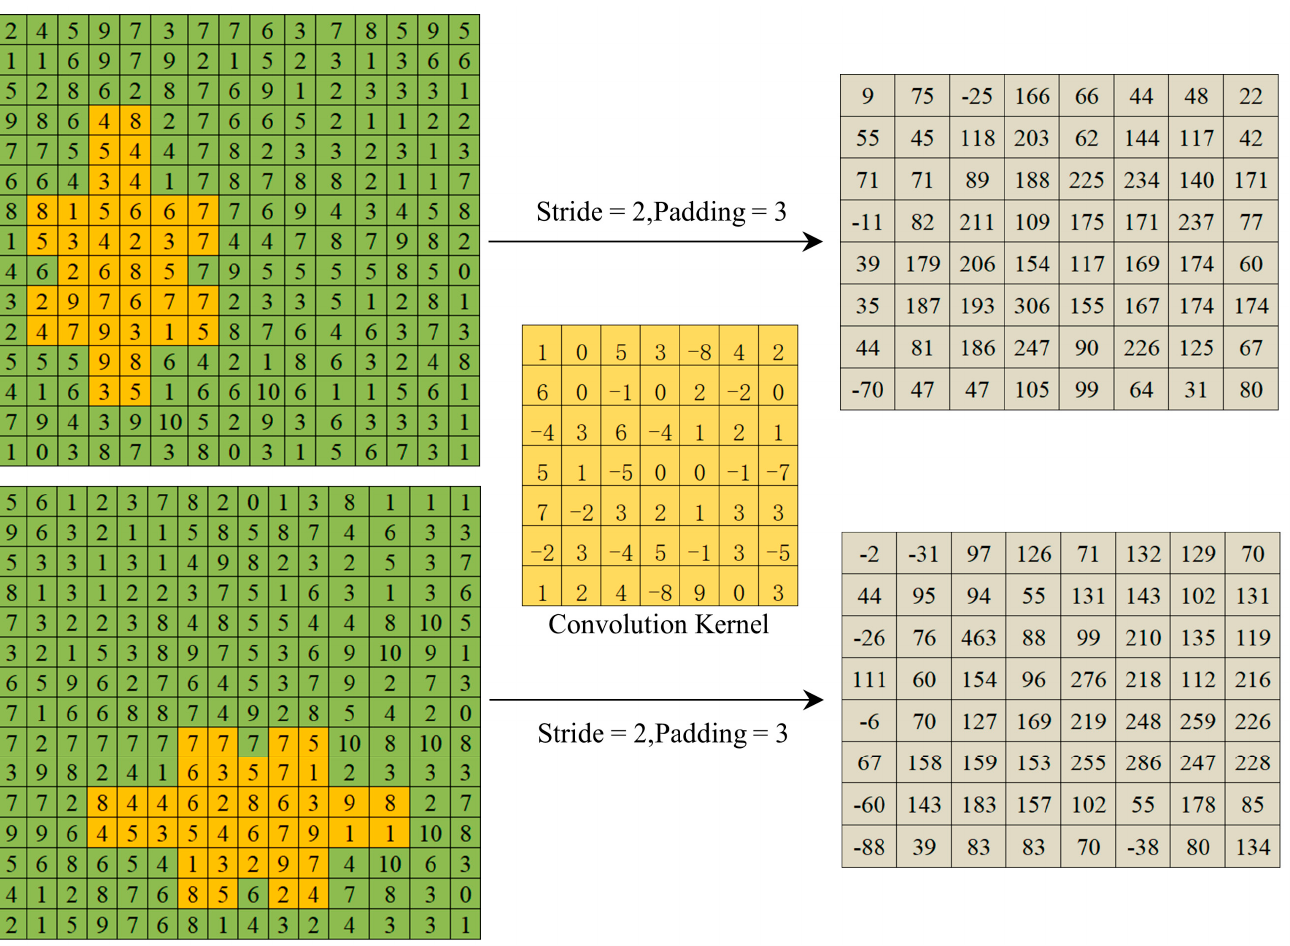
Figure 1. ( Top ) original image and feature map. ( Bottom ) 270° rotation and feature map. A rotation invariant detection network is usually capable of identifying the targets distributed at different angles in the image by adding rotation invariant layer, using rotation invariance regularization constraint or directly using data augmentation [17,45,46]. The targets of aircrafts in the image are mostly distributed at random angles, which can make the network have rotation invariant to a certain extent by the training of dataset. Therefore, the strategy of multi-angle features driven proposed in this paper did not focus on the rotation invariant but emphasized the use of differences caused by image rotation. It performed multiple feature extractions at different angles for the input image. The purpose is to reduce the loss of target features and improve the performance of the model. Figure 2 shows the process of multi-angle features driven strategy. In order to extract multi-angle features, we designed the multi-angle transformation module. It performs multi-angle (0 ◦ , 90 ◦ , 180 ◦ , 270 ◦ and mirror image) transformation on the remote sensing image and inputs it into the trained target detection network for